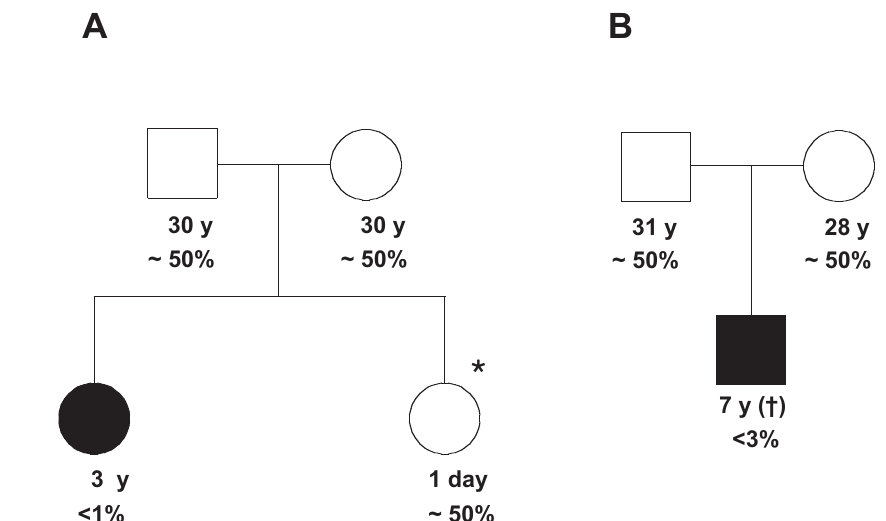
Figure 3 Pedigrees of two families with hereditary TTP due to constitutional ADAMTS-13 deficiency. Rectangles symbolise male and circles female family members, open symbols indicate healthy and filled symbols affected subjects. Individual ADAMTS-13 activity (% of normal human plasma pool) at diagnosis and present age (y) are indicated. A. Norwegian family. The affected girl was diagnosed to have severe constitutional ADAMTS-13 deficiency at the age of 20 months after several bouts of severe thrombocytopenia and/or anaemia. She is currently treated with regular plasma infusions and doing well. * indicates the newborn girl whose ADAMTS- 13 activity in cord blood permitted to exclude hereditary TTP. B. Turkish family. The patient had been treated for idiopathic thrombocytopenia and/ or haemolytic anaemia since infancy. Diagnosis of hereditary TTP was first suggested by autopsy findings and confirmed by ADAMTS-13 activity measurement post-hoc as well as family analy-